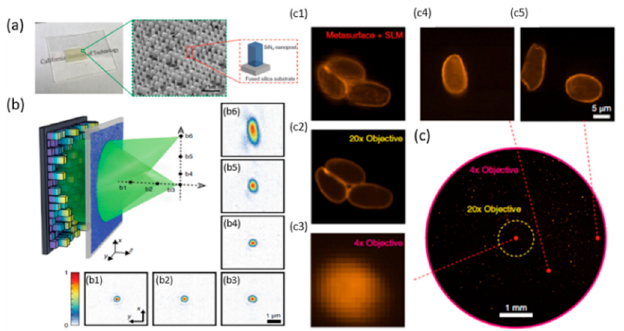
Figure 2. Disorder-engineered metasurfaces. ( a ) Photograph and SEM image of a fabricated disorder- engineered metasurface. ( b ) Schematic of optical focusing assisted by the disordered metasurface. The incident light is polarized along the x direction (b1–b6). ( c ) Low-resolution bright-field image captured by a conventional fluorescence microscope with a 4 × objective lens (NA = 0.1). (Reproduced from [27] with permission.)